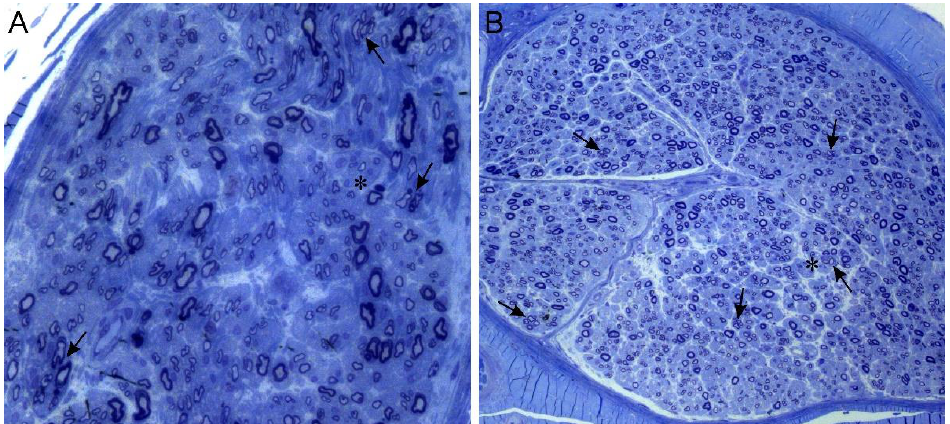
Figure 2. Sural nerve biopsies. Semithin sections stained with toluidin blue. ( A ) (20×): 17-year-old